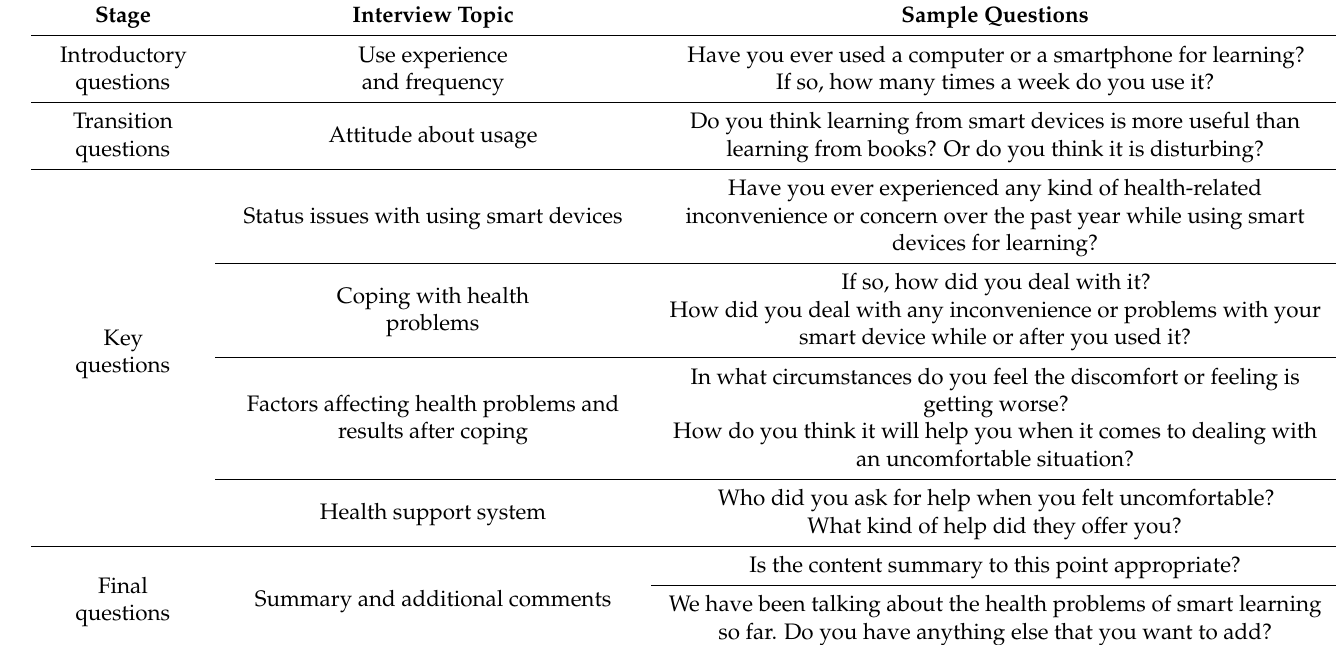
Table 1. In-depth interview